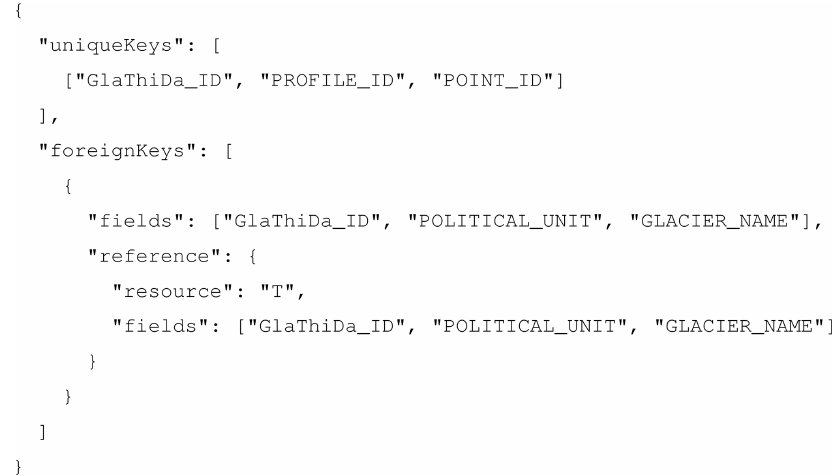
mented for changes to existing data, and the patch version is incremented for changes to metadata